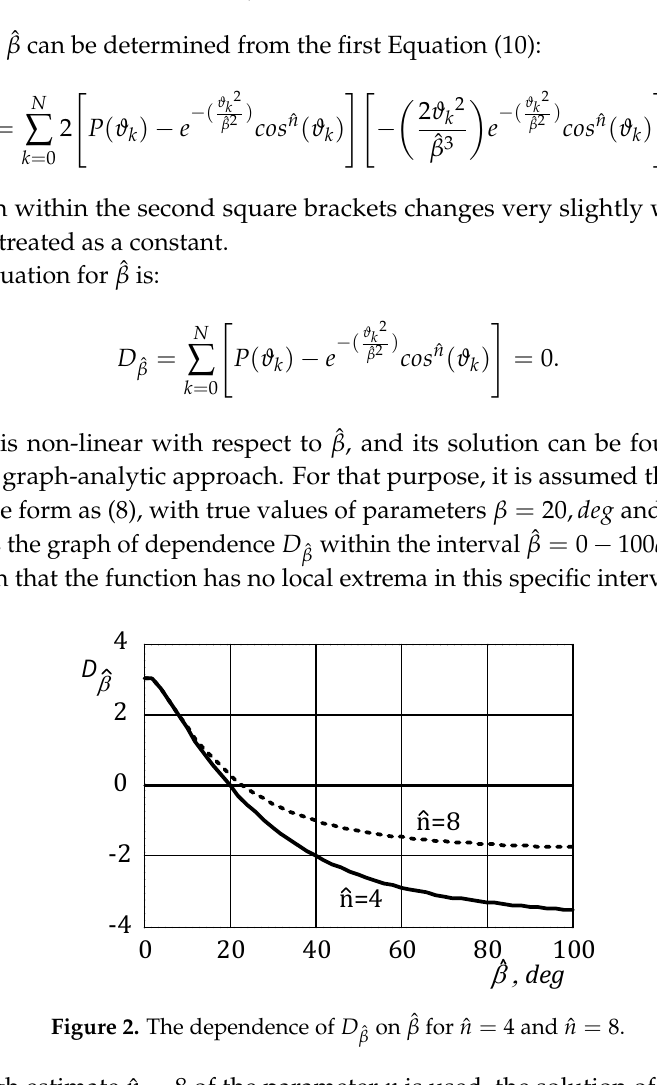
on ˆ β for ˆ n = 4 and ˆ n = β ˆ  on for ˆ 4 n = and ˆ 8 n = . D ˆ 